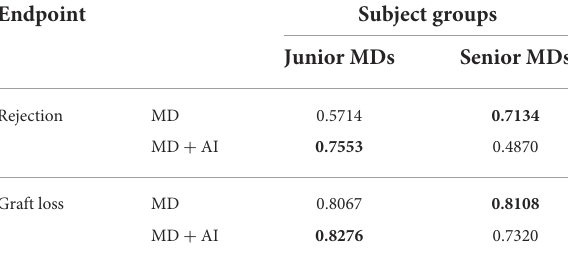
TABLE 2 AUC-ROC results on the reader study test set of AI, MD, and MD + AI for the endpoints death-censored graft failure and rejection.